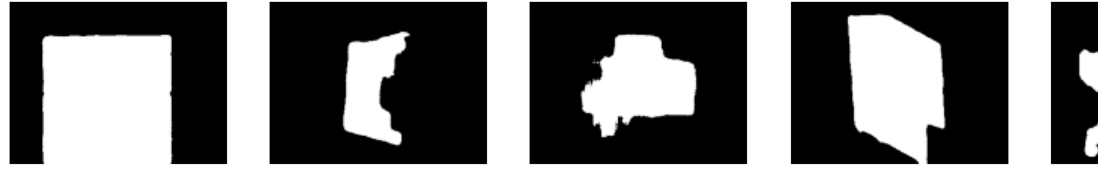
Figure 8. Evaluation with test data U-net